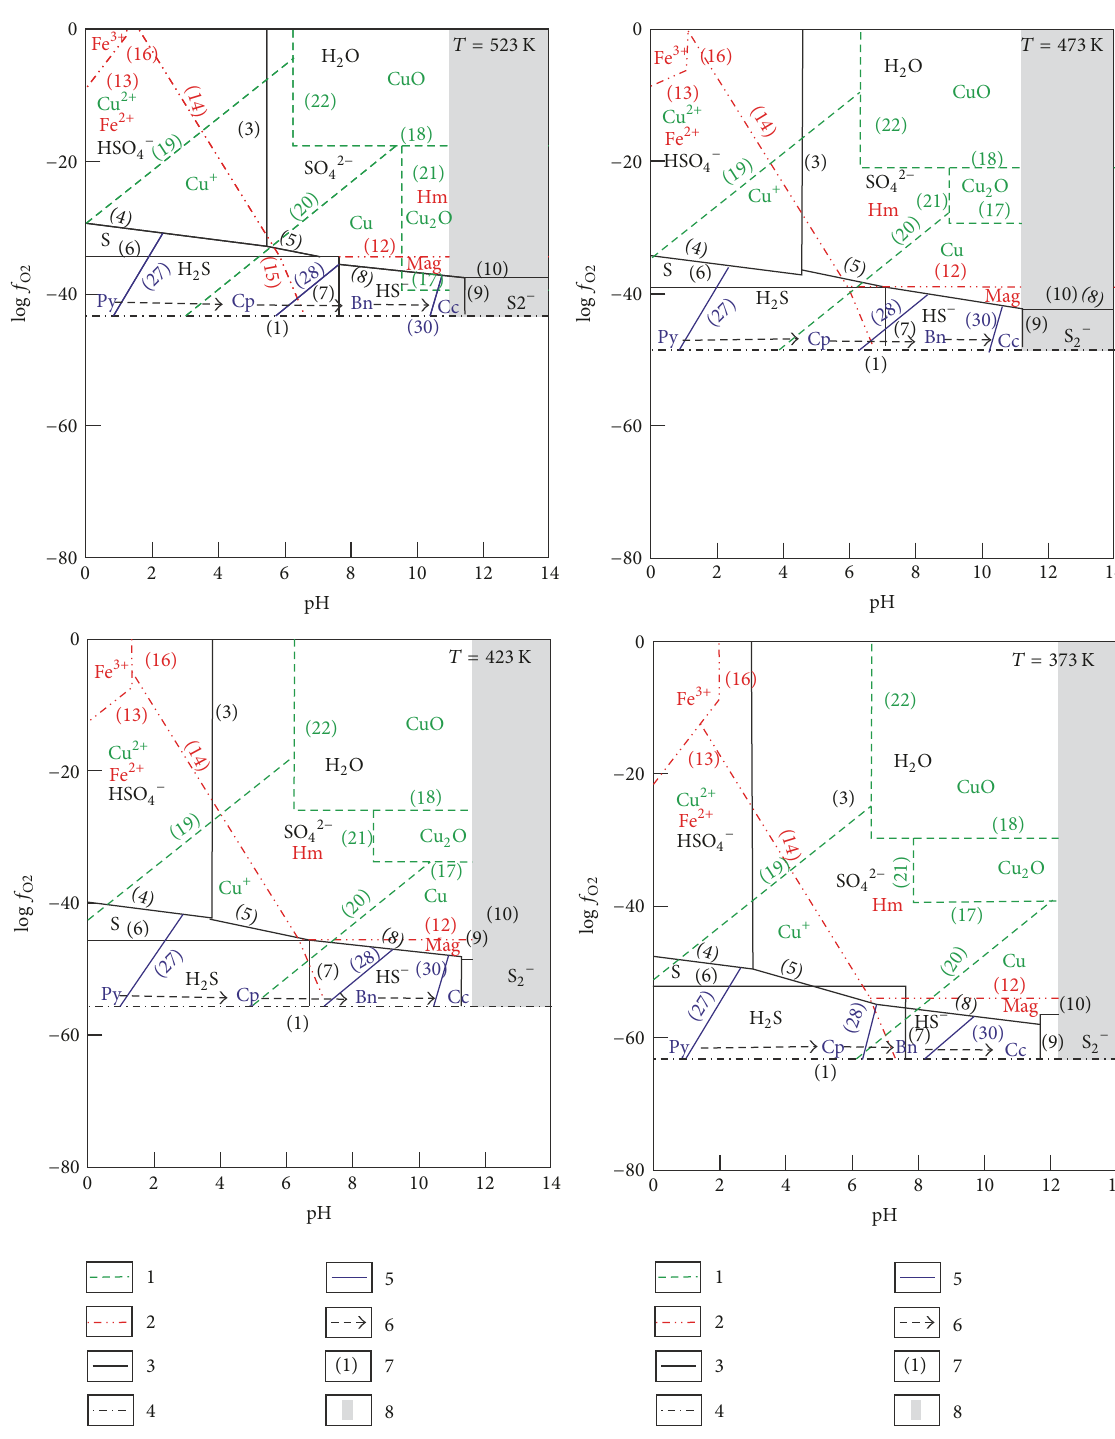
Figure 8: pH-Eh diagram of Cu-O -S-Fe system at 373 K–523 K ( ∑ 𝑆 = 0.02 𝑚𝑜𝑙/𝐿, ∑ 𝐹𝑒 = 10 − 8 𝑚𝑜𝑙/𝐿, ∑ 𝐶𝑢 = 10 − 8 𝑚𝑜𝑙/𝐿 ). 1: balance line 2 of Cu; 2: balance line of Fe; 3: balance line of S; 4: balance line of H 2 O; 5: balance line of sulfide; 6: order of sulfide precipitation; 7: number of chemical equations in Table 2; and 8: nonexistence in fact because of K at the different temperatures. Py: pyrite; Cp: chalcopyrite; Bn: H 2 O bornite; Cc: chalcocite; Hm: hematite; and Mag: